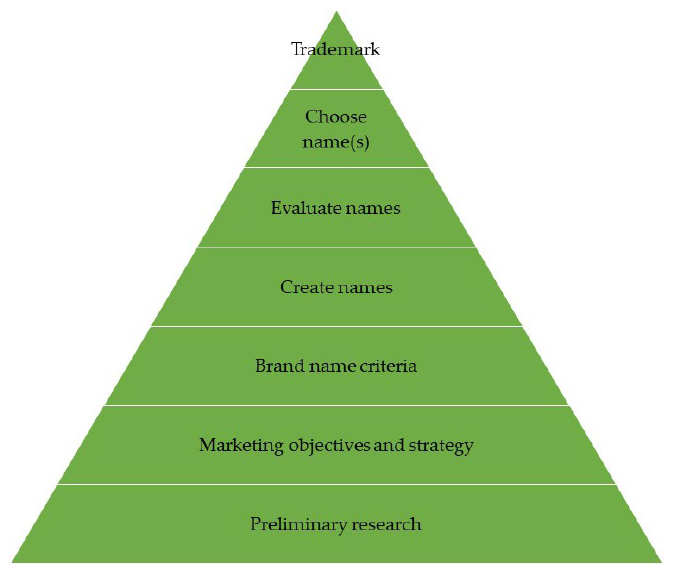
Figure 1. A step-by-step process proposed for the creation of brand names for fruit varieties (Source: Pyramid structure, authors’ own; content of pyramid [28–36]).